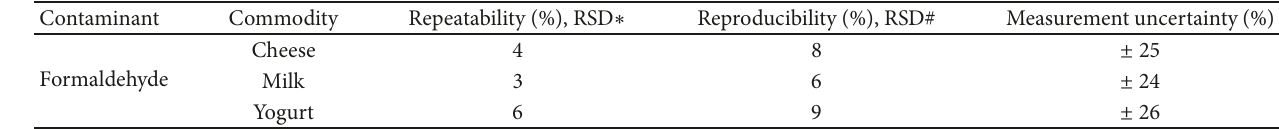
Table 2: Precision contribution to the measurement